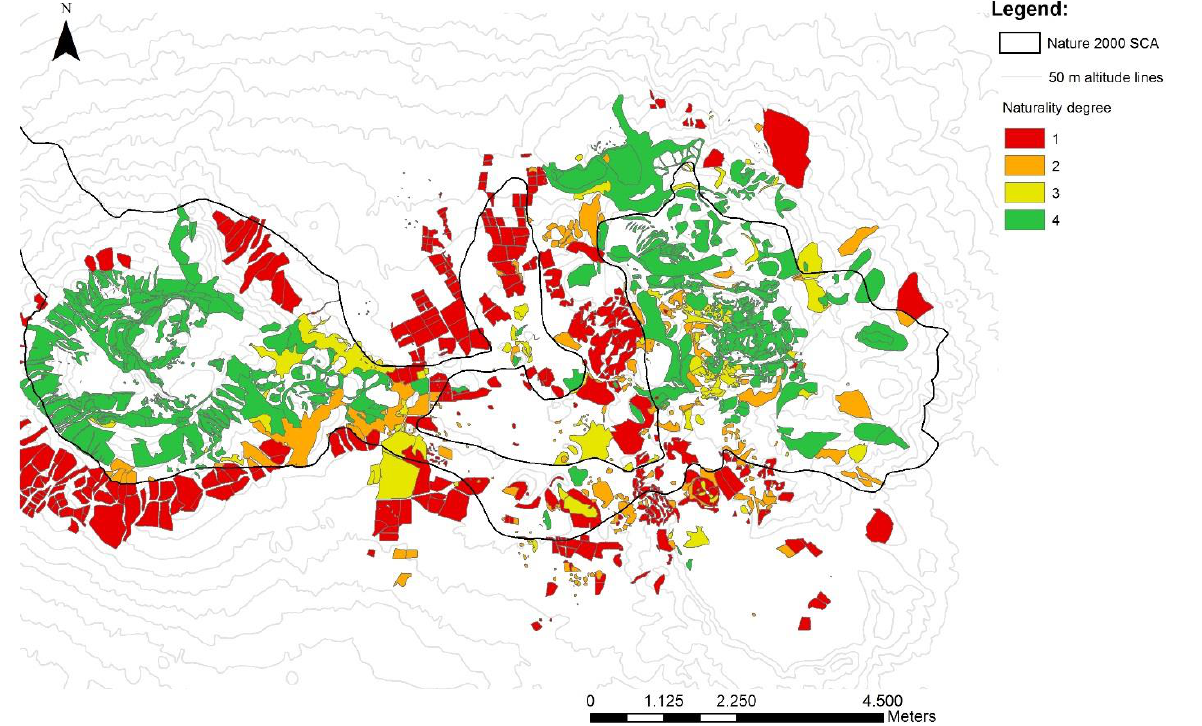
Figure 4. Naturalness map of Terceira Island peatlands. This map distinguishes naturalness classes for peatlands: 1 = disturbed; 2 = altered; 3 = conserved; 4 = wild. Digital base map: Military Map